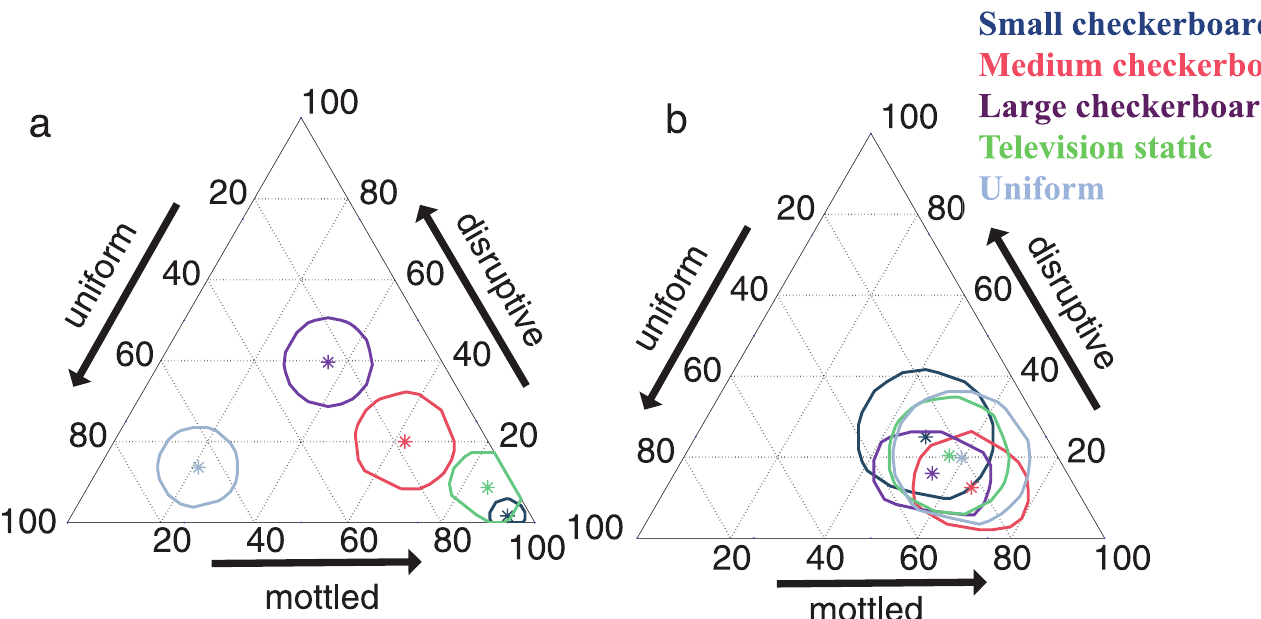
Fig 7. Average response of cuttlefish to each of the five stimulus patterns. The asterisk indicates the average value, and the surrounding shapes are the bootstrapped 95% confidence intervals. See text and Fig 4 for information on reading ternary plots. (a) Average response to different bottom stimuli. (b) Average response to different side stimuli.